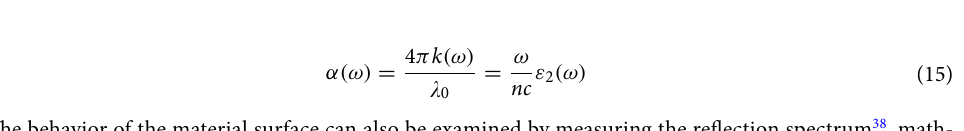
Figure 4. Pressure-influenced change in dielectric function, ( a ) real component, and ( b ) imaginary